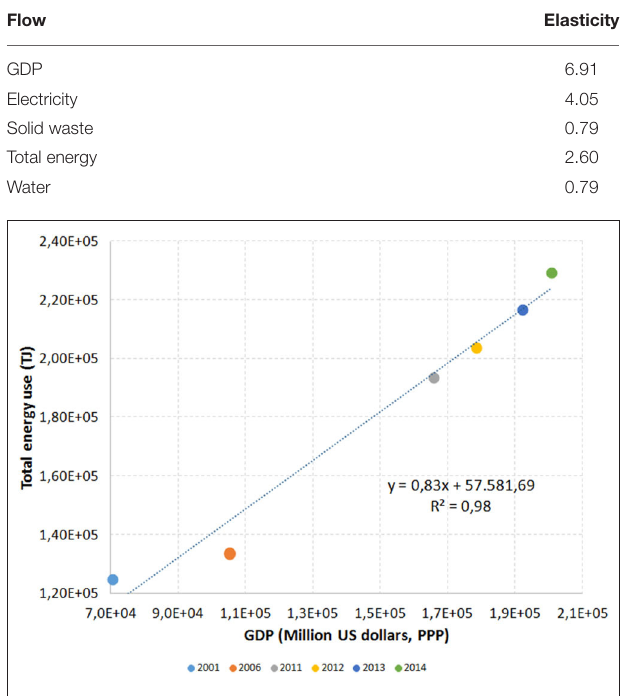
FIGURE 2 | Evolution of total energy use vs.